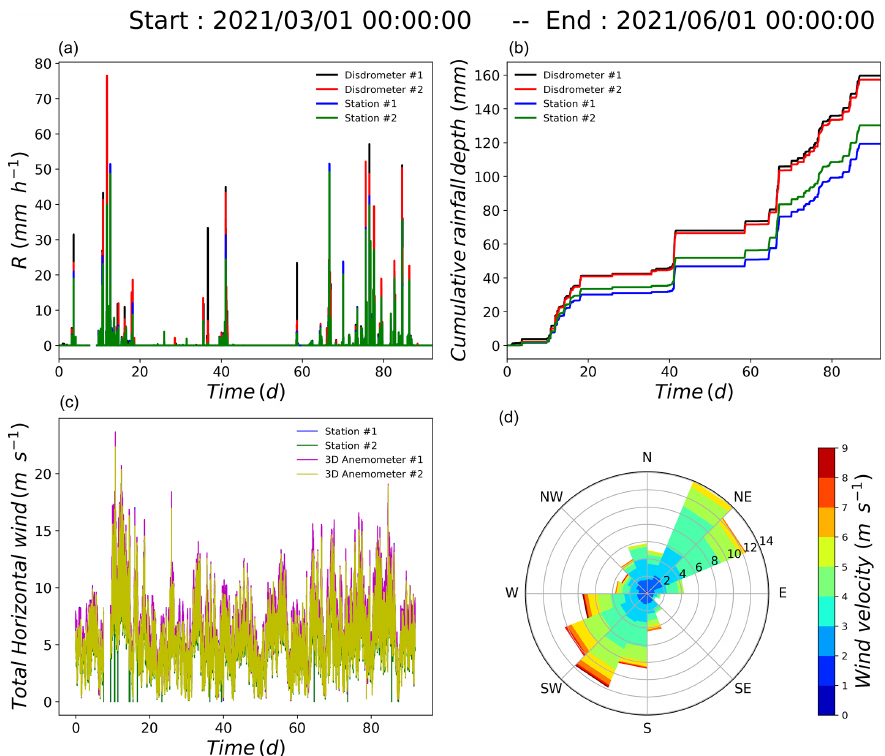
Figure 6. Rain rate (a) and cumulative rainfall depth (b) vs. time over the 3 months of the measurement campaign, retrieved from the two disdrometers and the two meteorological stations. We use 1min average wind (c) and a wind rose (d) computed from the 3D sonic anemometer no. 1, which is located at the top of the